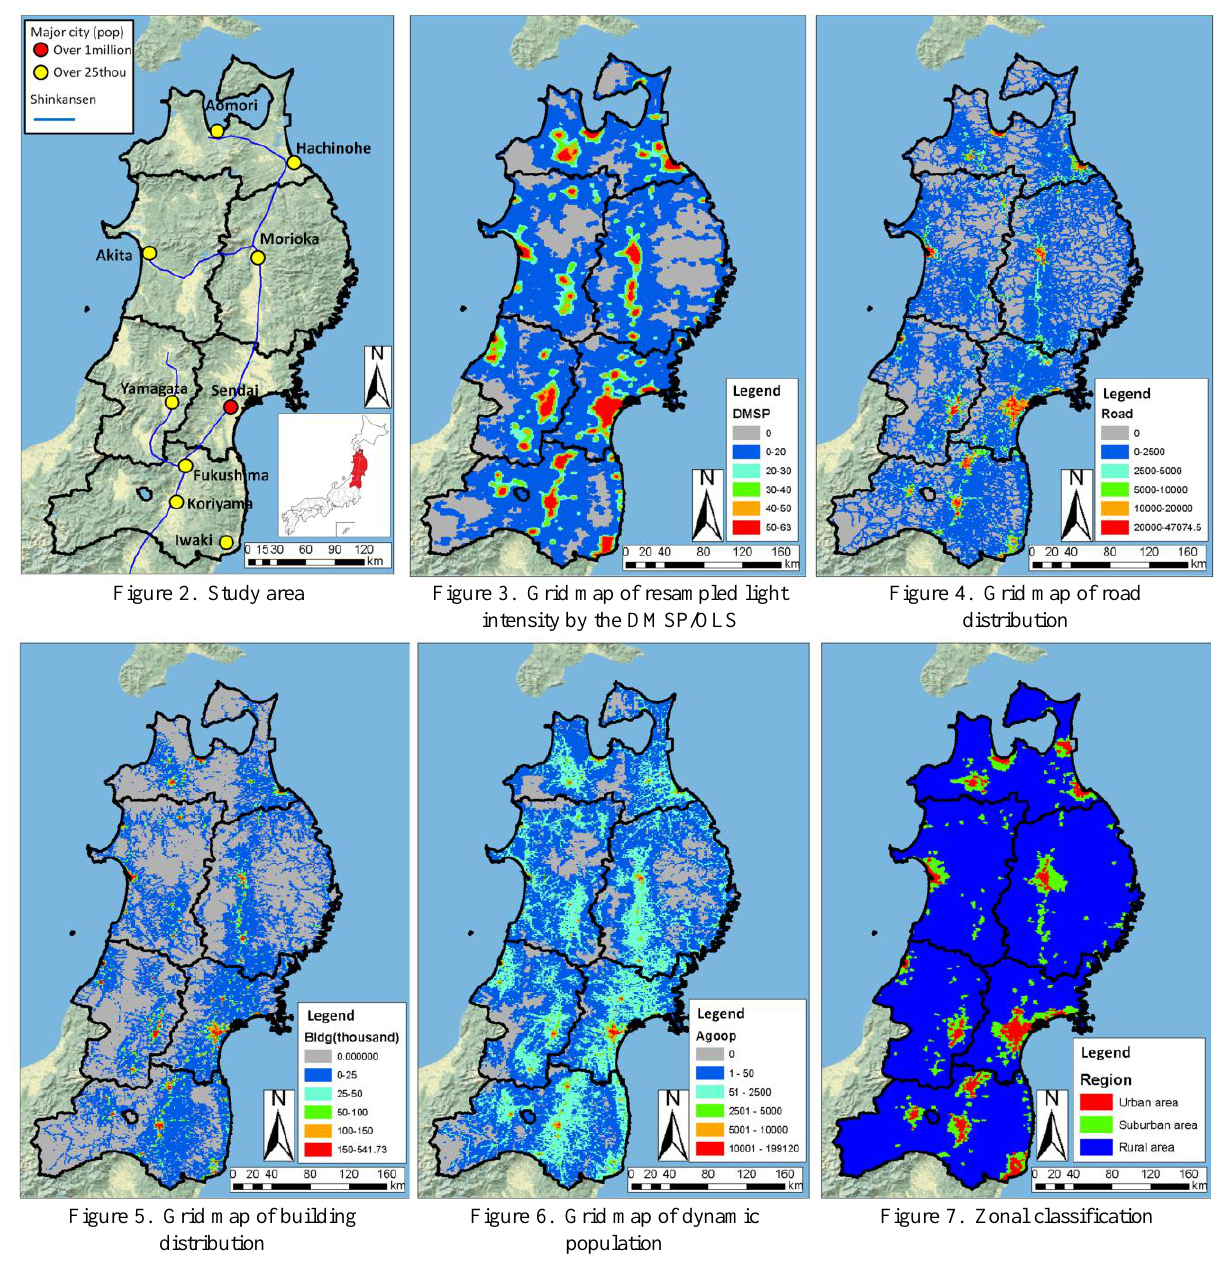
Figure 7. Zonal classification